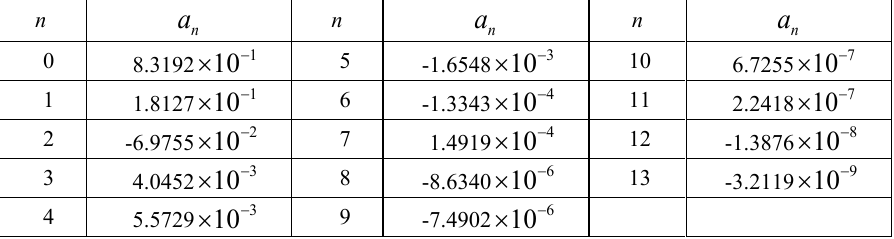
Fig. 1. Mean of fitting uncertainties of FIT 1 with different fitting orders. Table 2. CDF polynomial fit coefficients for first-order Tracy-Widom distribution.